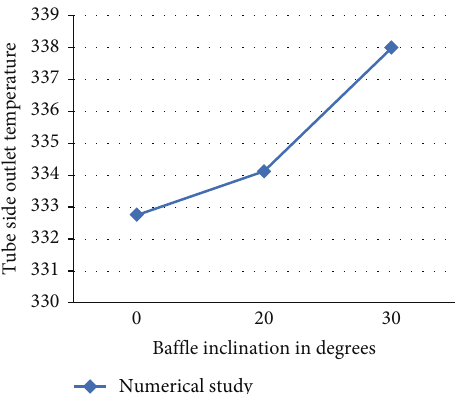
Figure 14: E ff ect of tube side outlet temperature for alumina with di ff erent ba ffl e inclinations.